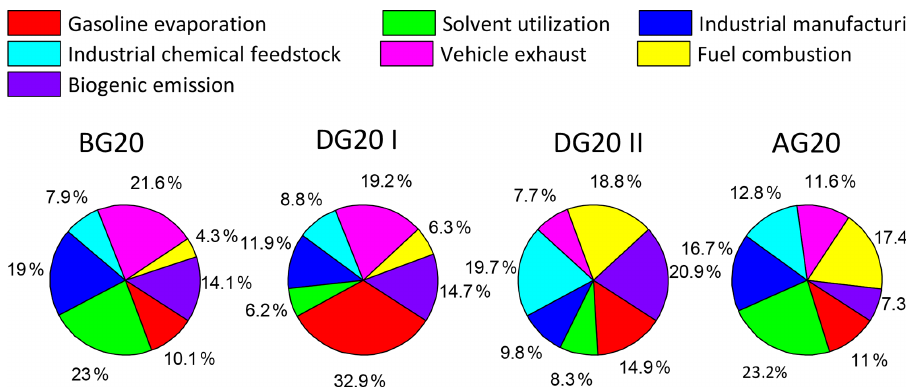
Figure 6. Variation in the sources (percentage) during the four periods.